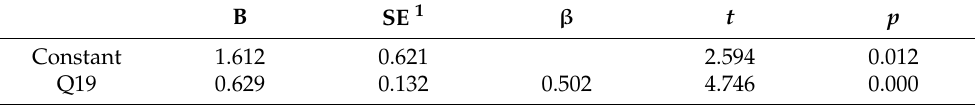
Table 7. A regression model of the convenience of quarantine life in the CTC (Q10) ( N = 69). B SE 1 β t p Constant 1.612